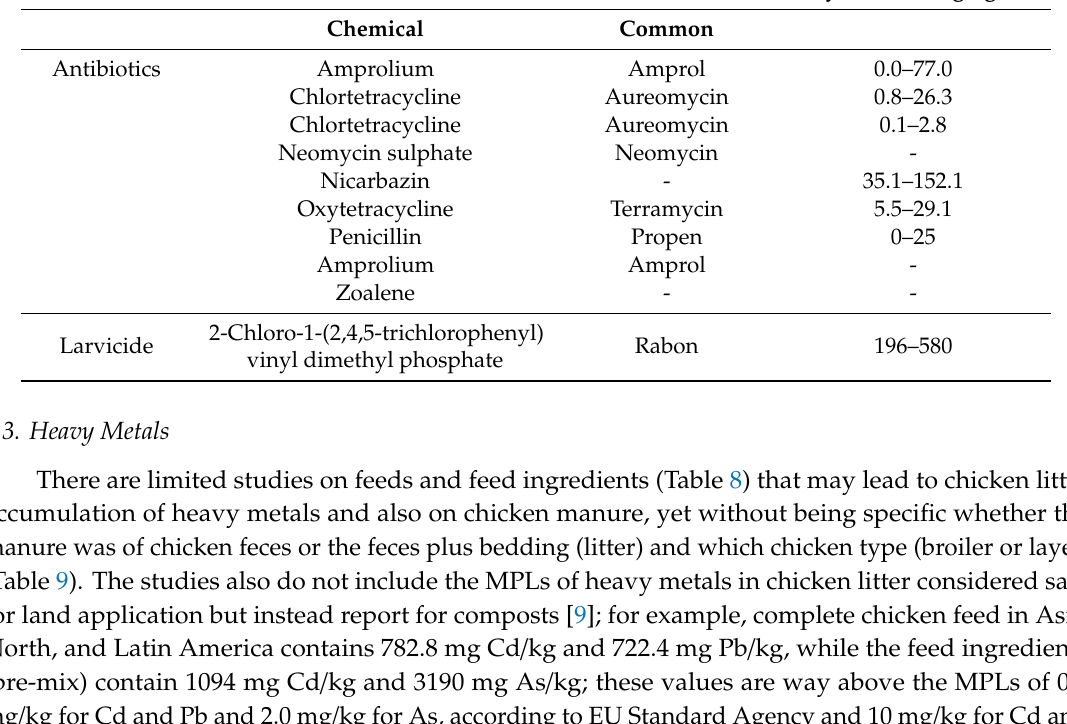
Table 6. Antibiotics and larvicides commonly used in chicken production as taken from [1].